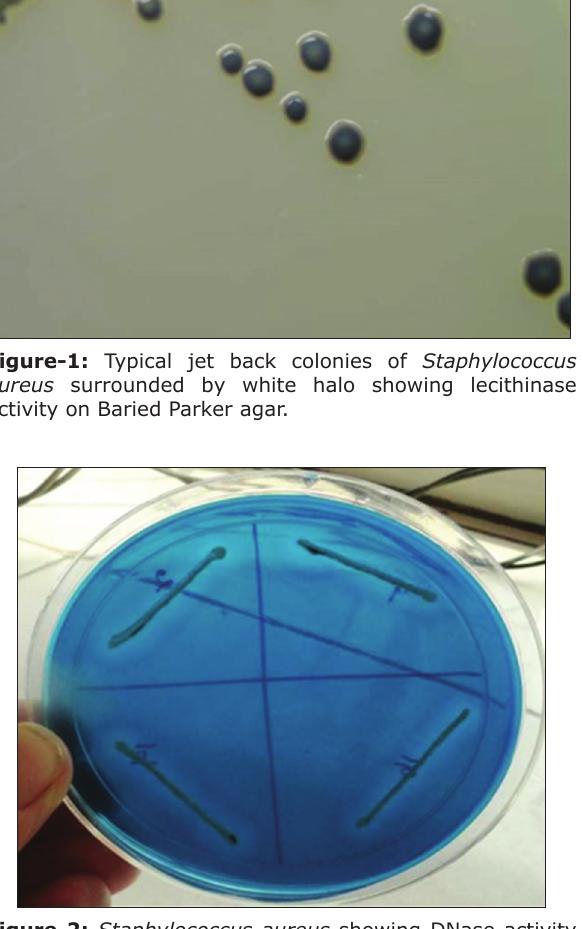
Figure-2: Staphylococcus aureus showing DNase activity on DNase agar.